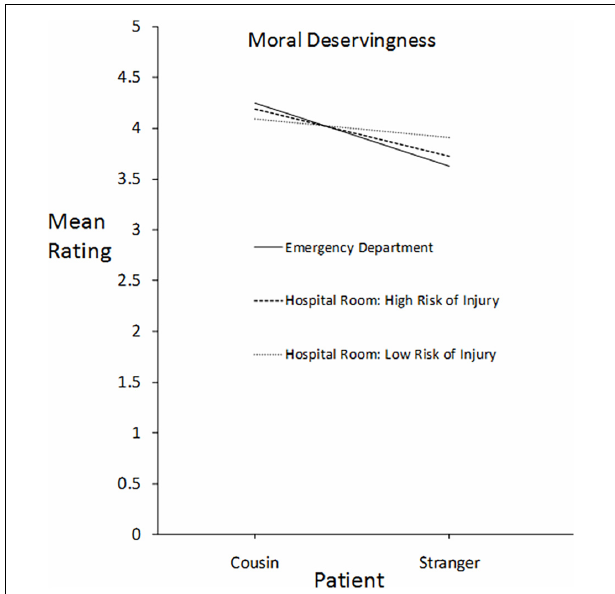
FIGURE 3 | For patients differing in kinship relationship to the participants (cousin vs. stranger), participants’ mean ratings of each patient’s moral deservingness of immediate care in three settings differing in severity of risk to the patients: death, high risk of injury, and lower risk of